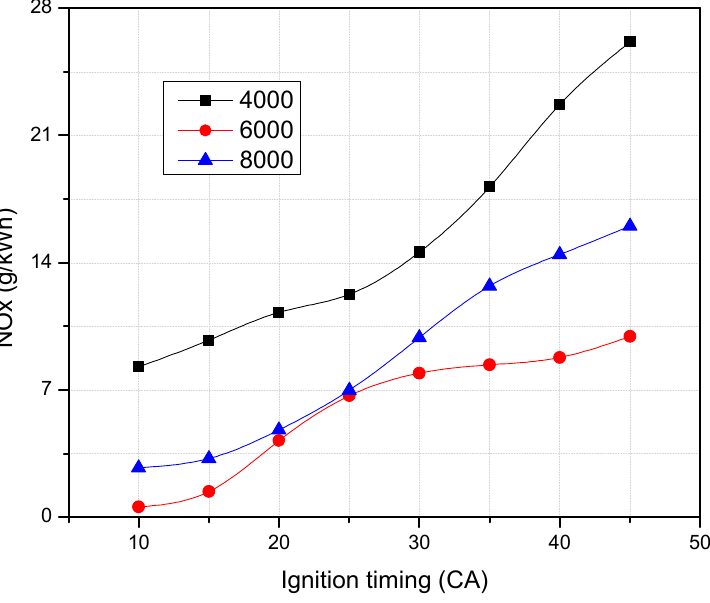
Figure 18. NOx emissions versus ignition timing.